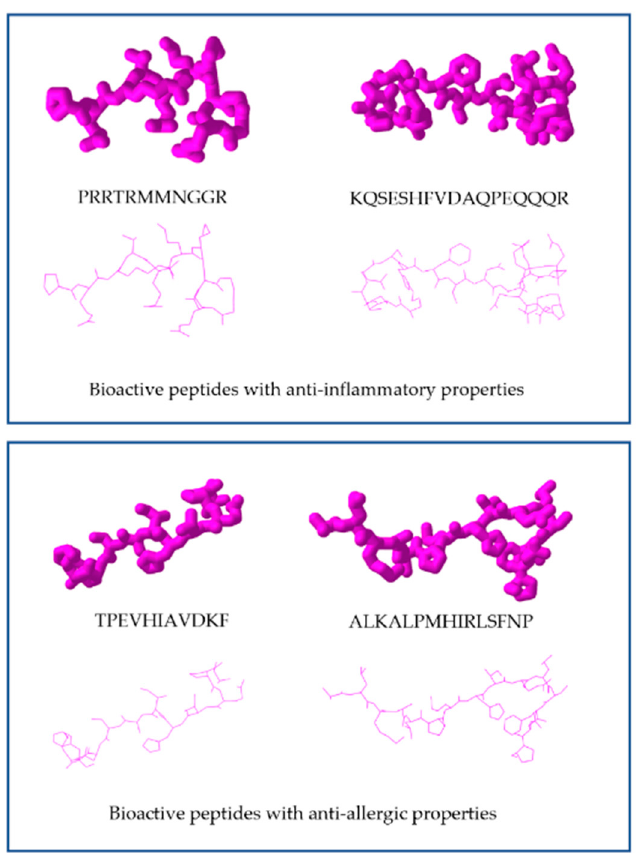
Figure 3. Representation of the secondary structure of different peptides that display anti-allergic and anti-inflammatory properties. Peptide structures were generated by the PEPstrMOD server [167] and visualized in Icn3d viewer (https://www.ncbi.nlm.nih.gov/Structure/icn3d/full.html).